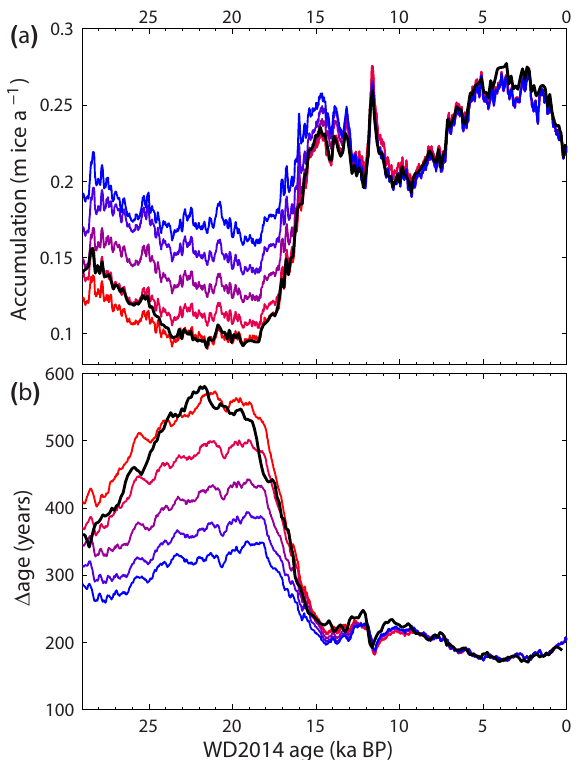
Figure 4. Impurity enhancement of densification rates at WD. Den- sification modeling results for (a) accumulation rates and (b) (cid:49) age. We use Ca sensitivities β = 0 (red) through β = 1 × 10 − 2 (blue), in steps of 2 . 5 × 10 − 3 (shades of deep purple). Black curves give A and (cid:49) age from ice-flow modeling and λ(z)